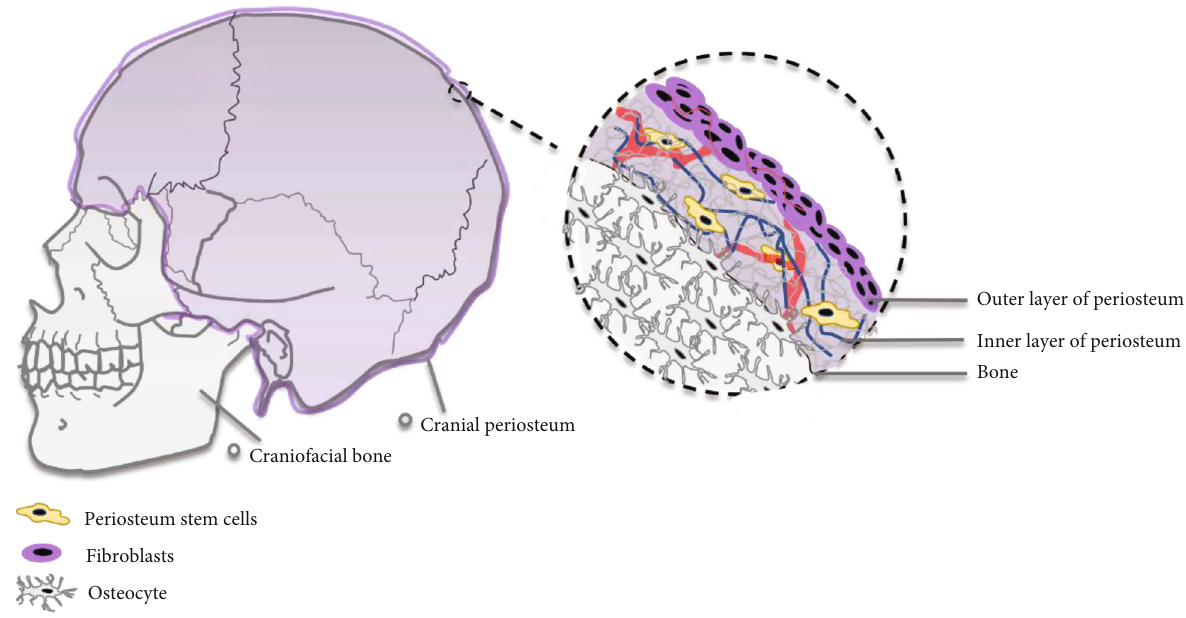
Figure 1: Stem cell distribution in the cranial bone. The stem cells are located in the inner layer of calvarium